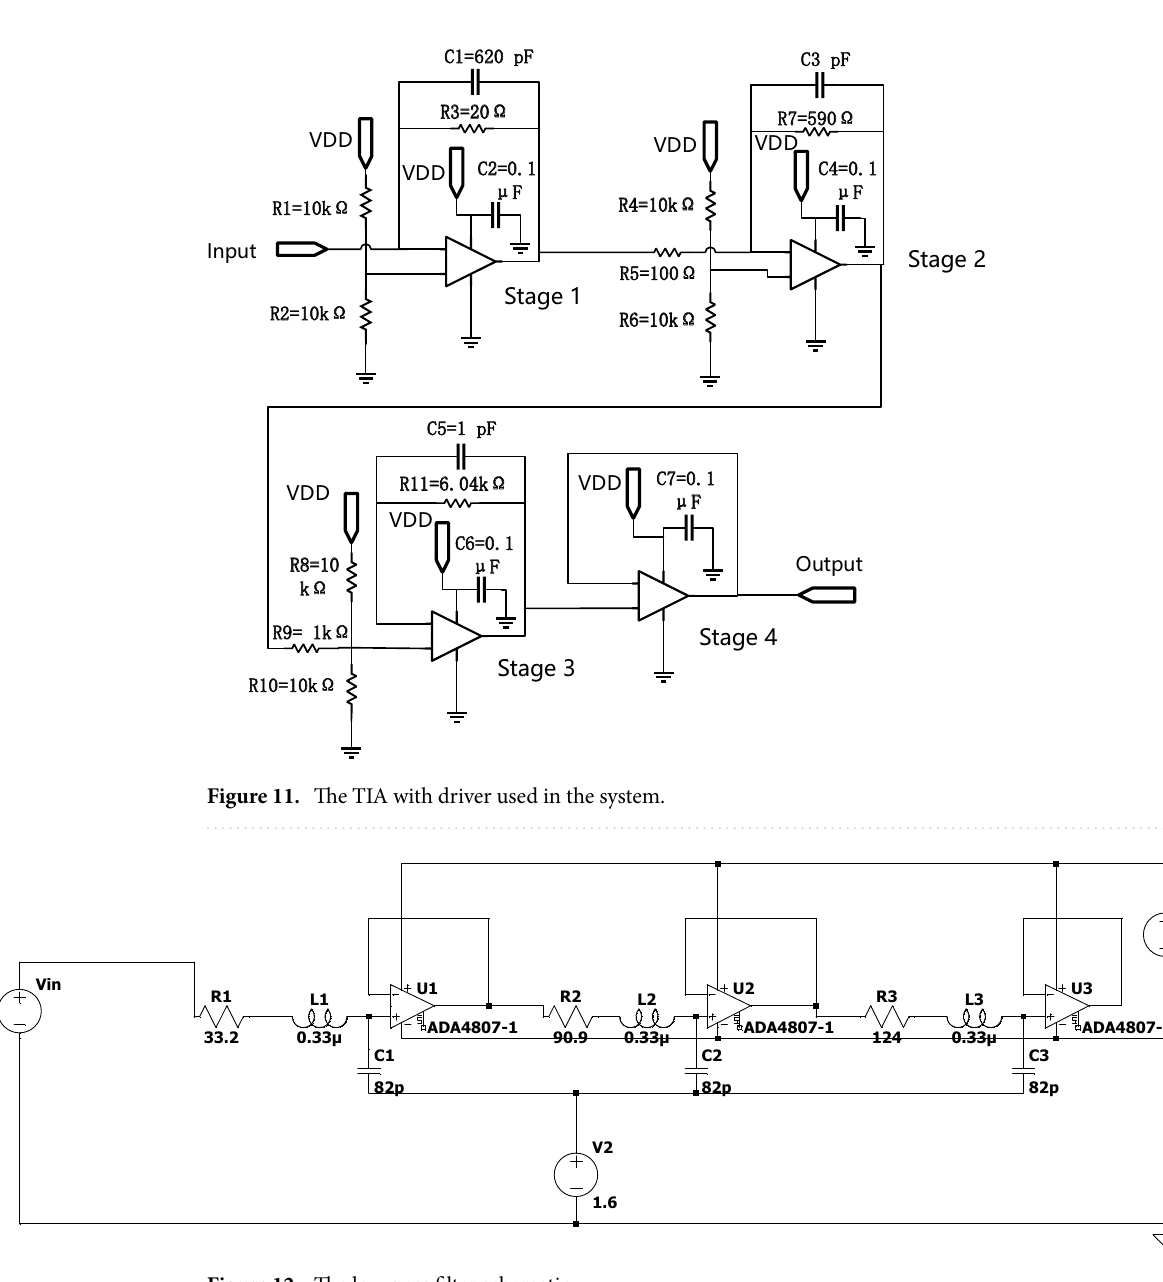
Figure 12. The low-pass filter schematic.